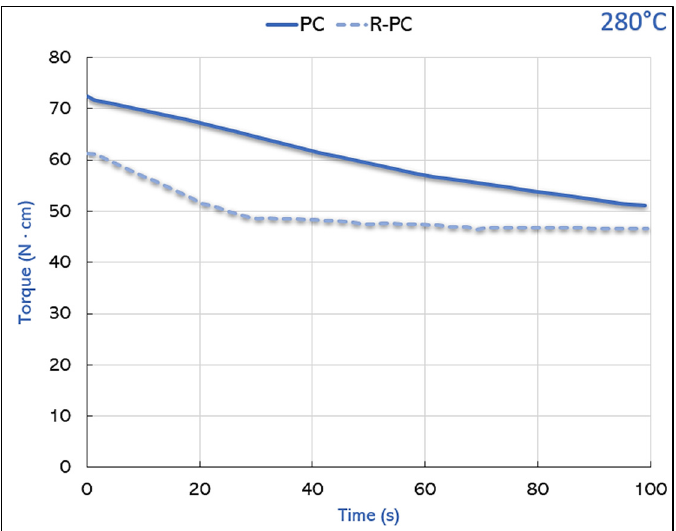
Figure 2. Torque trend for PC and R-PC.